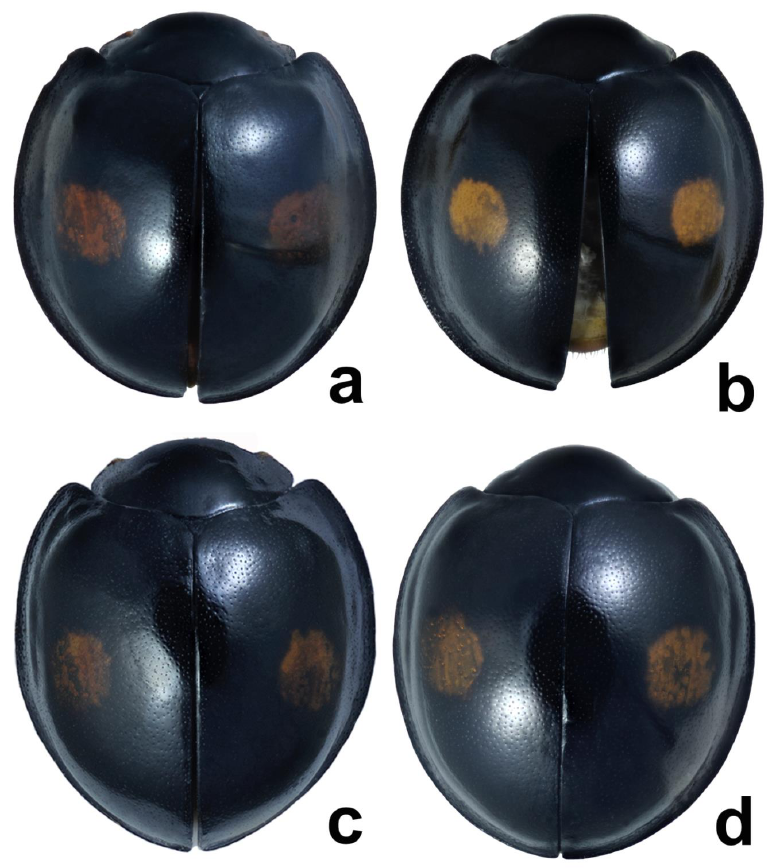
Figure 2. Chilocorus renipustulatus , total dorsal view. ( a ) Male from Germany; ( b ) male from Japan, Honshu; ( c ) female from Germany, Saxony; ( d ) female, Japan, Honshu.